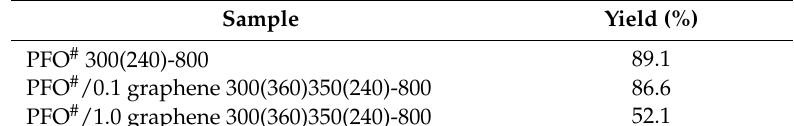
Table 6. Yields of Carbon Fibers after Oxidation at 500 ◦ C in Air.